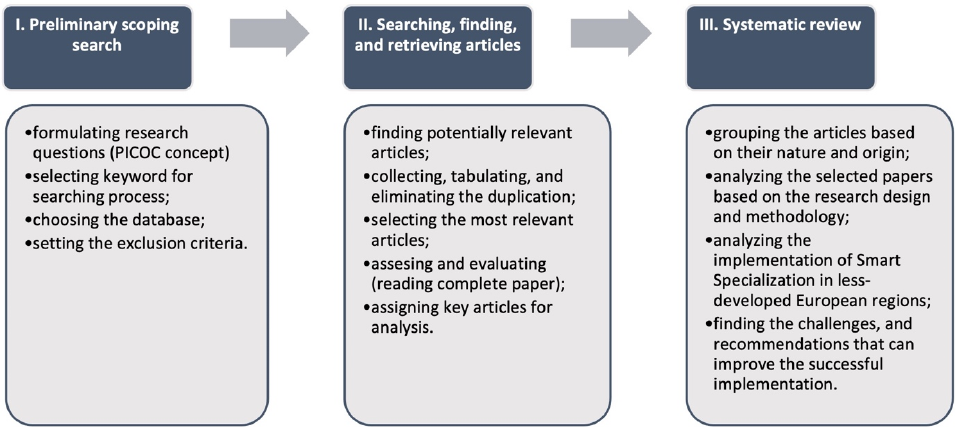
Figure 2: The research